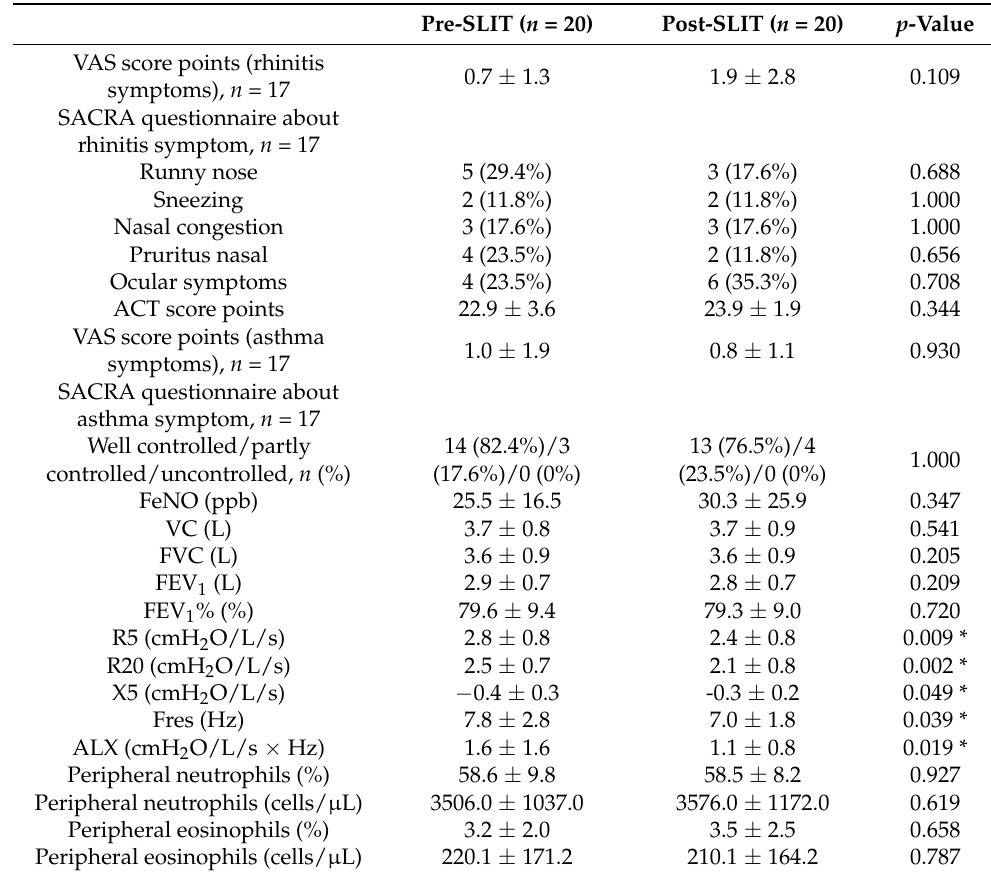
Table 2. Baseline characteristics of the study population and dynamics of the parameters in patients treated with